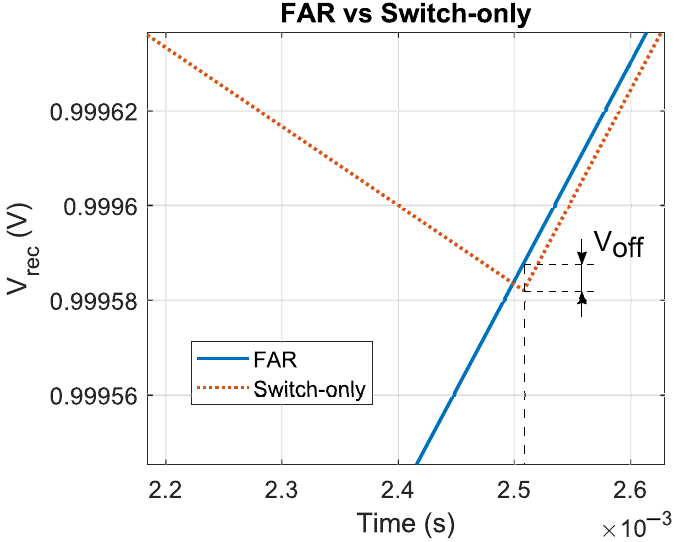
Figure 8. Detail plot around t = t 1 of Figure 7a,b